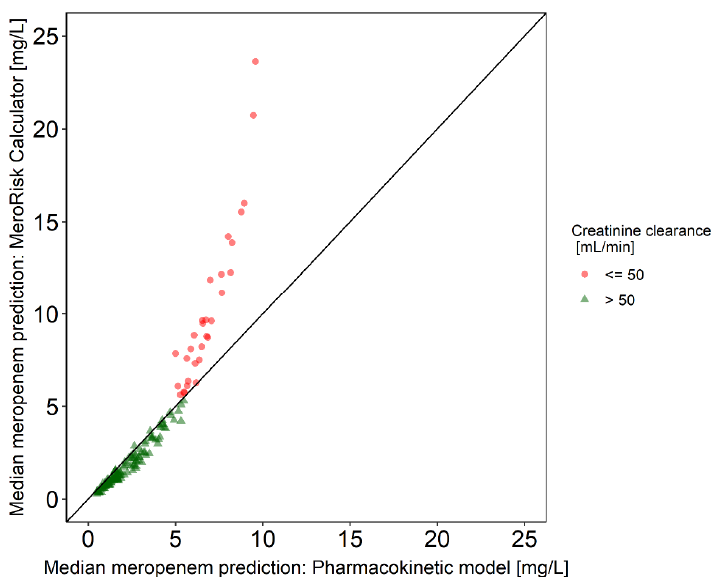
Figure 1. Median meropenem concentrations 8 h after dose predicted by pharmacokinetic model and MeroRisk-Calculator. Median predictions (PK model: stochastic simulations ( n = 2000), MeroRisk-Calculator: classic theory of linear models [11]) for patients ( n = 124) with creatinine clearance calculated using Cockcroft–Gault Equation (CLCRCG) > 50 mL/min (green triangles) and patients ( n = 31) with CLCRCG ≤ 50 mL/min (red points) 8 h after standard dose (1 g meropenem, 0.5 h infusion). Line: Line of identity.